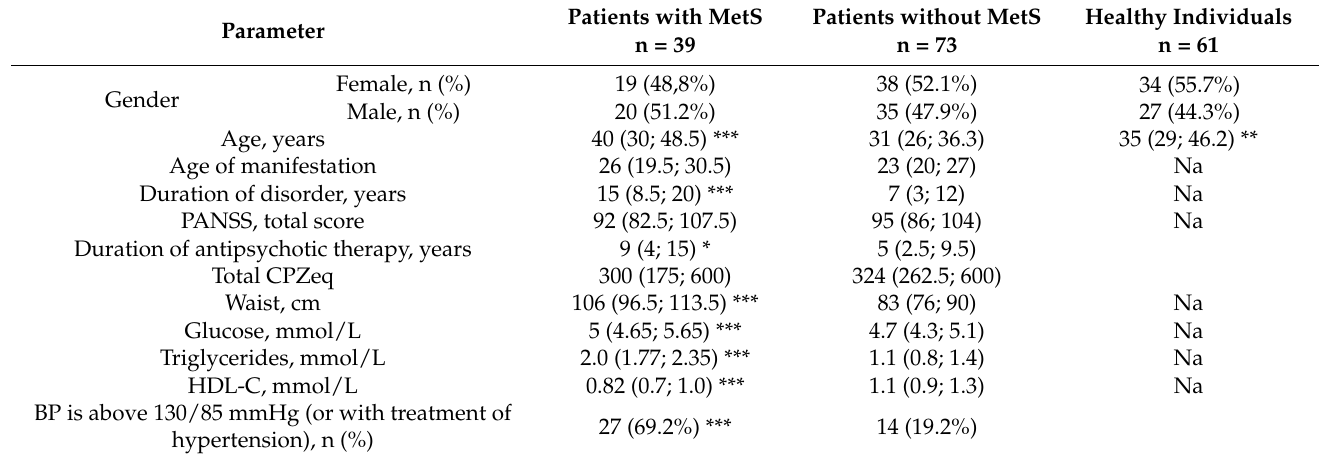
Table 1. Basic characteristics of the patients with schizophrenia and healthy individuals included in the